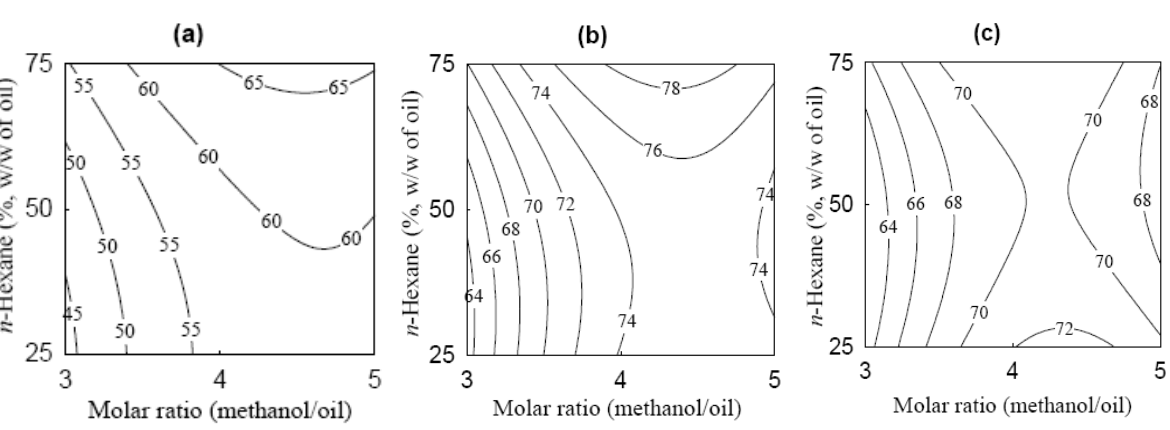
Figure 2. Contour plots of molar conversion using soybean oil as a feedstock at different